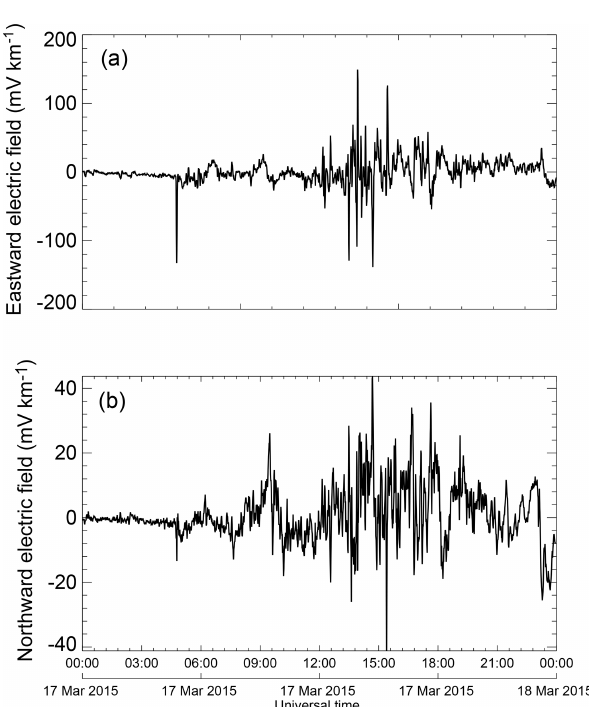
Figure 2. Data of the eastward (a) and northward (b) electric field during the 17 March 2015 geomagnetic